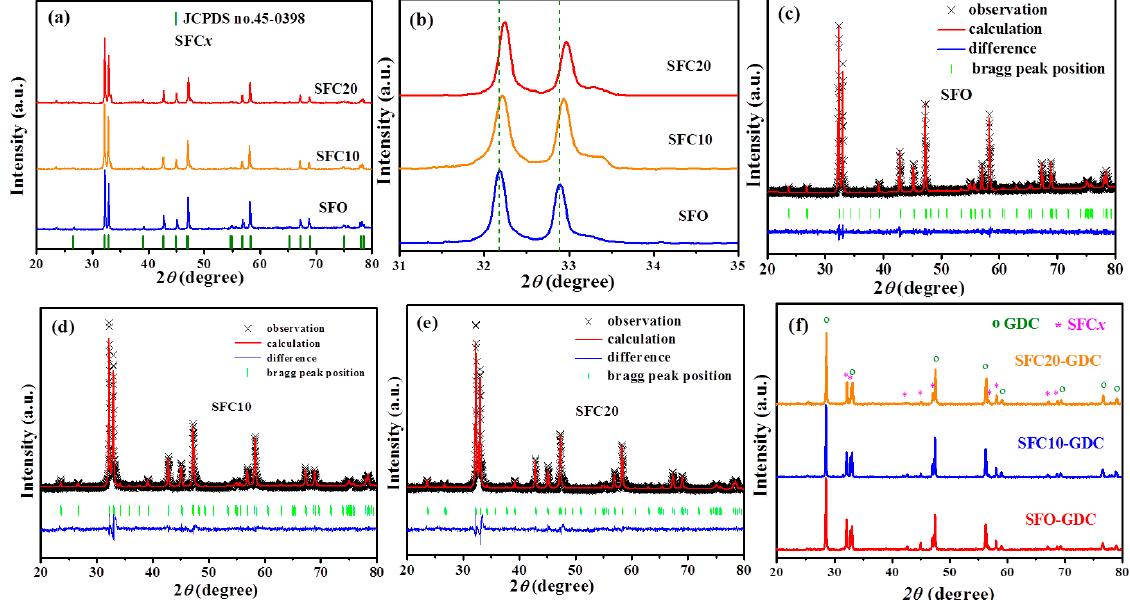
Figure 1. ( a ) XRD spectra of SFC x samples; ( b ) XRD pattern of SFC x within a diffraction angle of 2 θ = 31–35 ◦ ; the refined XRD patterns of SFO ( c ), SFC10 ( d ) and SFC20 ( e ); ( f ) XRD spectra of SFC x -GDC composite after being calcined at 1000 ◦ C for 12